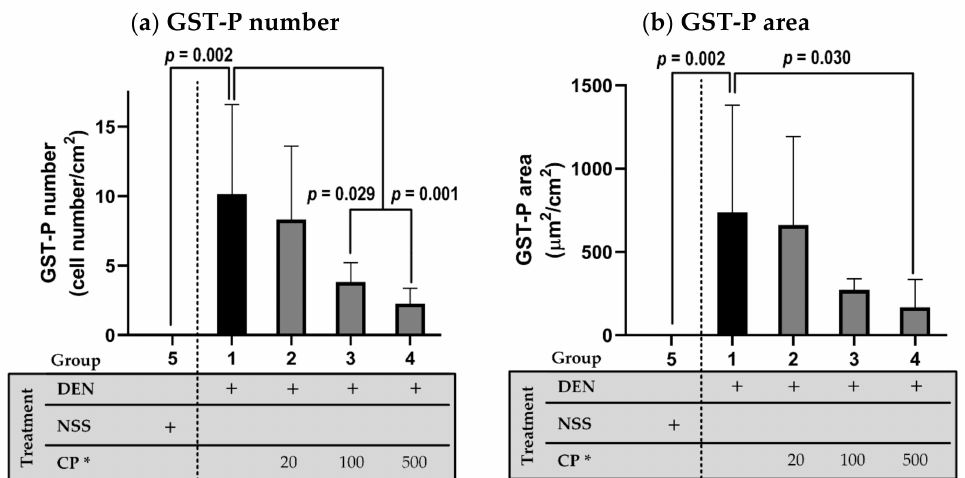
Figure 3. The effect of CP on GST-P positive foci formation as represented by a number ( a ) and area ( b ). DEN or NSS were initially administered at week 0 and 1. Then either DW (for groups 1 and 5) or CP were fed weekly starting from week 2 till the end of the experiment. Data displays non-normal distribution (Shapiro–Wilk and Levene’s test: p < 0.05) and was analyzed for statistical difference using nonparametric Mann–Whitney U test. * CP dosage unit; mg/kg BW.